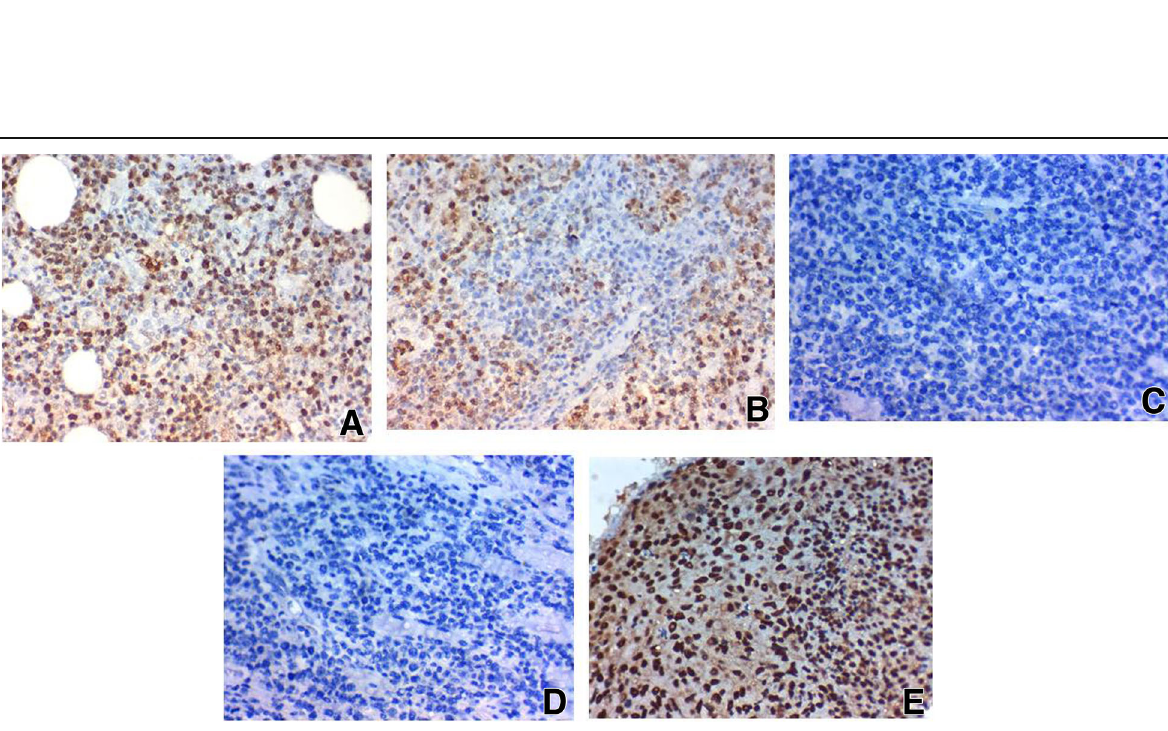
Fig. 2 Immunohistochemical expression of Fork head transcription factor (FOXP-1); ( a ) High nuclear FOXP-1 expression in DLBCL stage IV × 400 ( b ) High nuclear FOXP1 expression in DLBCL stage III × 400 ( c ) negative nuclear FOXP-1 expression in DLBCL stage I × 400. ( d ) Positive nuclear FOXP-1 expression in sections from squamous cell carcinoma of the cervix as appositive control of the marker × 400 ( e ) Negative control by replacement of the primary anti- FOXP-1 antibody by phosphate buffered saline ×